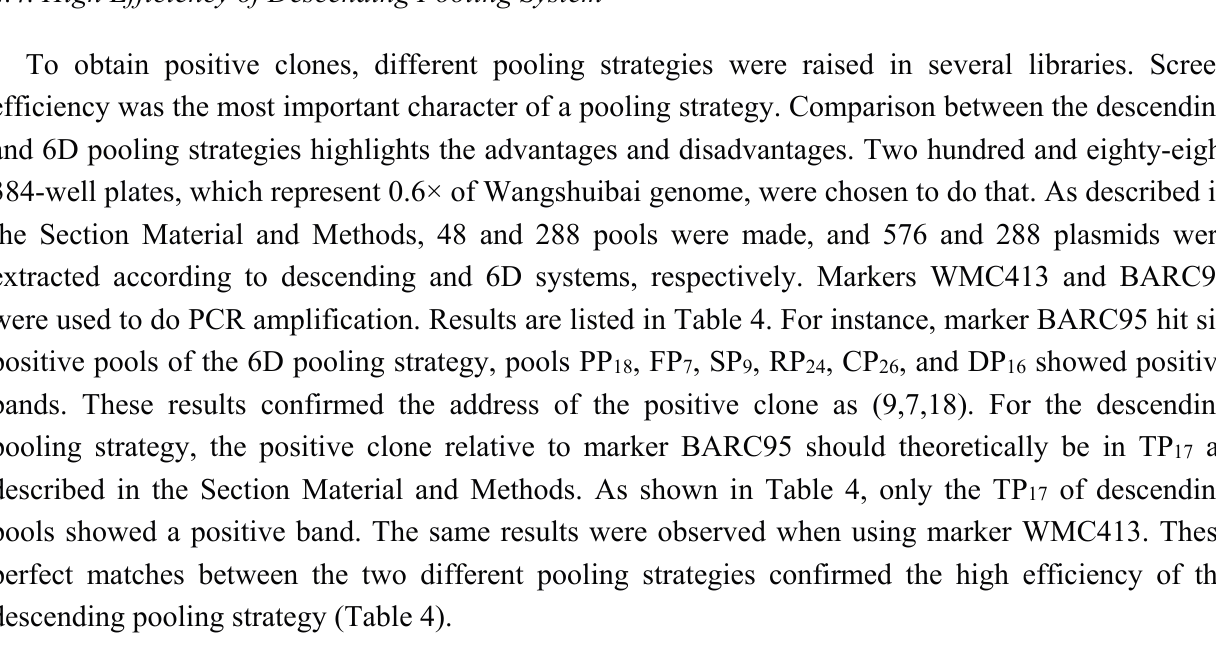
Table 4. Comparison between 6D and descending pooling